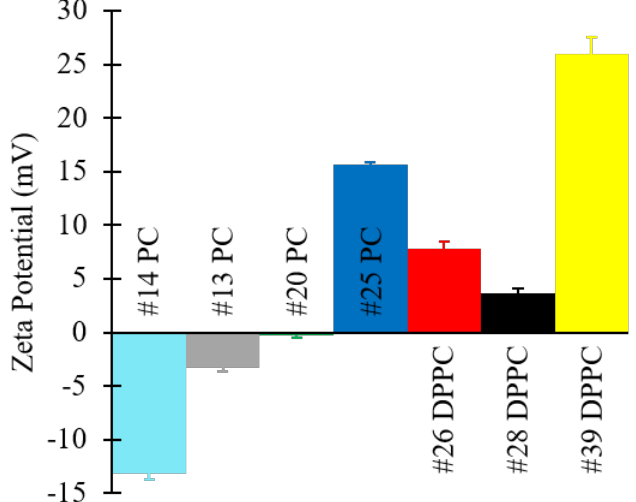
Figure 10. Zeta potential values of liposomes consisting of di ff erent lipid formulations. Data represent the means of three measurements with corresponding standard deviations. Refer to Table 1 (batch codes #14 PC, #13 PC, #20 PC, #25 PC, #26 DPPC, #28 DPPC, #39 DPPC) for the corresponding experimental conditions, lipid compositions, and numerical data of mean values and standard